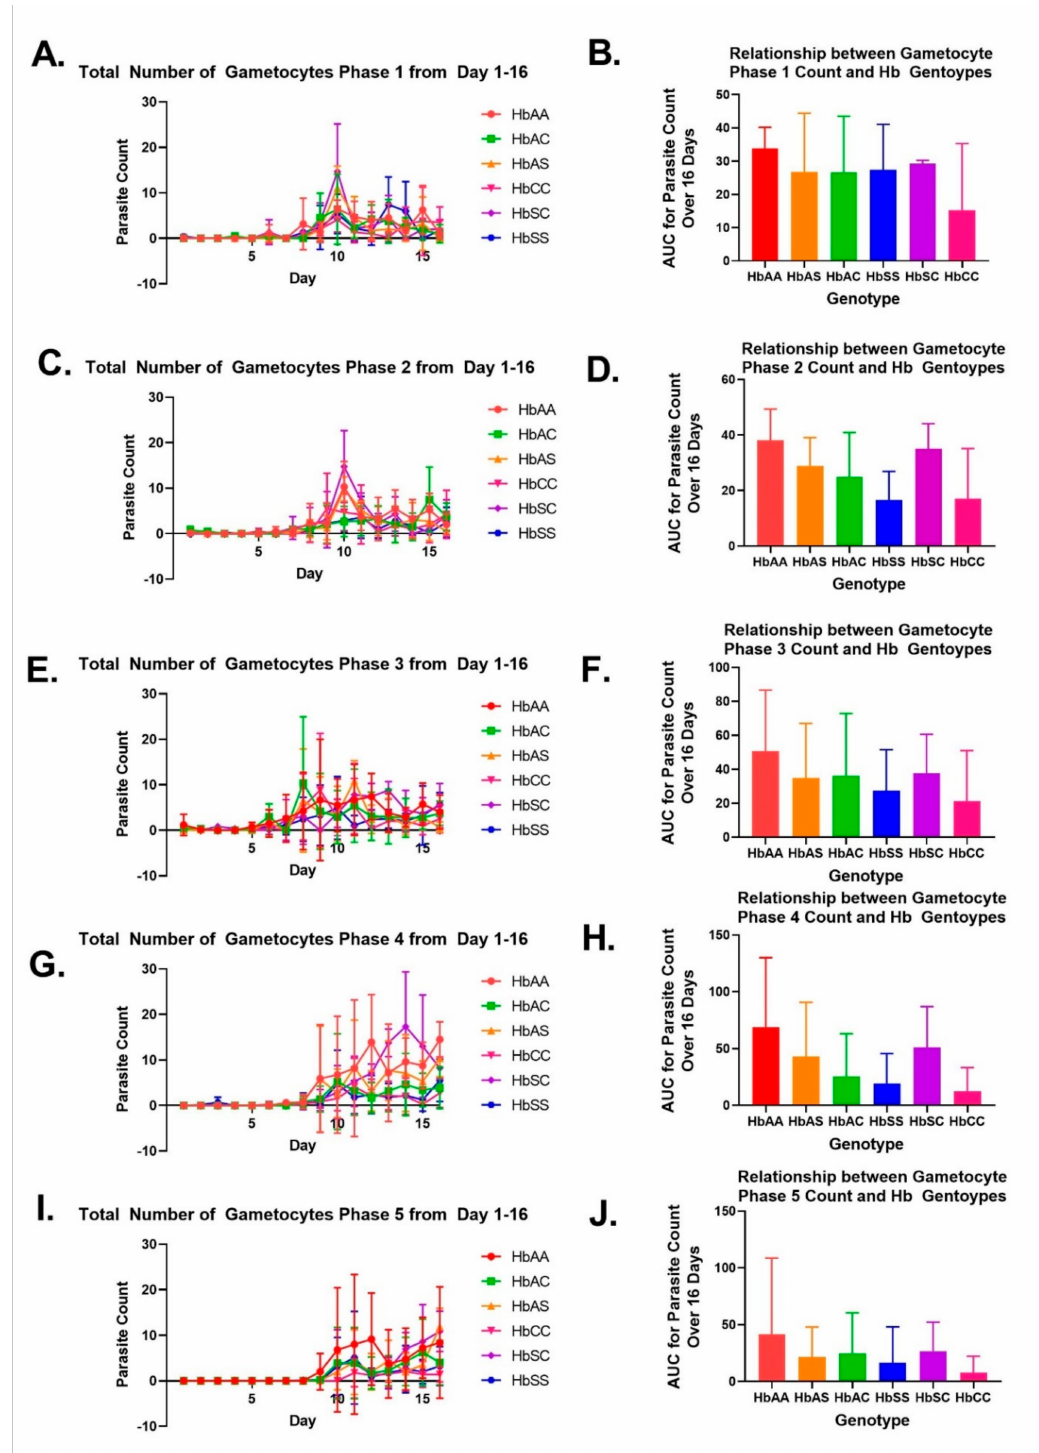
Figure 3. Gametocyte phase 1–5 counts for each sickle Hb genotype over 16 days. Red is for HbAA, orange for HbAS, green for HbAC, blue for HbSS, purple for HbSC, and pink for HbCC. Area under the curve (AUC) was used to estimate parasite counts over 16 days. A one-way ANOVA and a Tukey’s multiple comparison test were used. ( A , B ) illustrate phase-1 gametocyte counts for each genotype. ( C , D ) illustrate phase-2 gametocyte counts. ( E , F ) illustrate phase-3 gametocyte counts. ( G , H ) illustrate phase-4 gametocyte counts. ( I , J ) illustrate phase-5 gametocyte